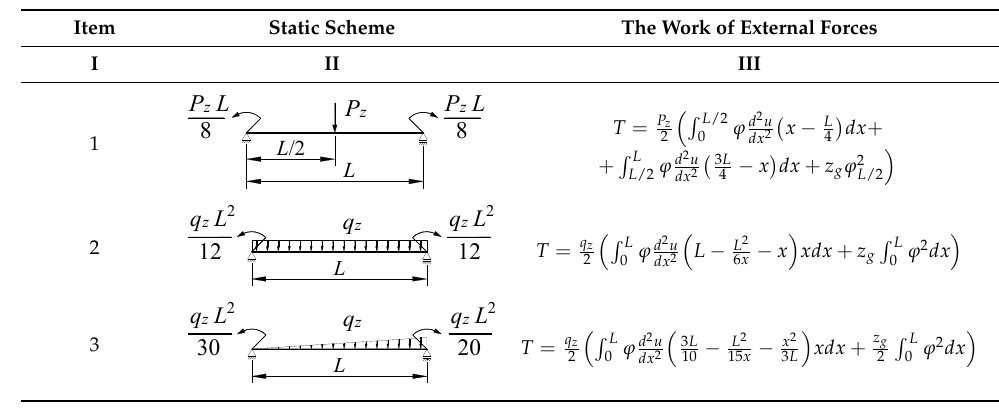
Table 2. Work done by external forces for selected static schemes.